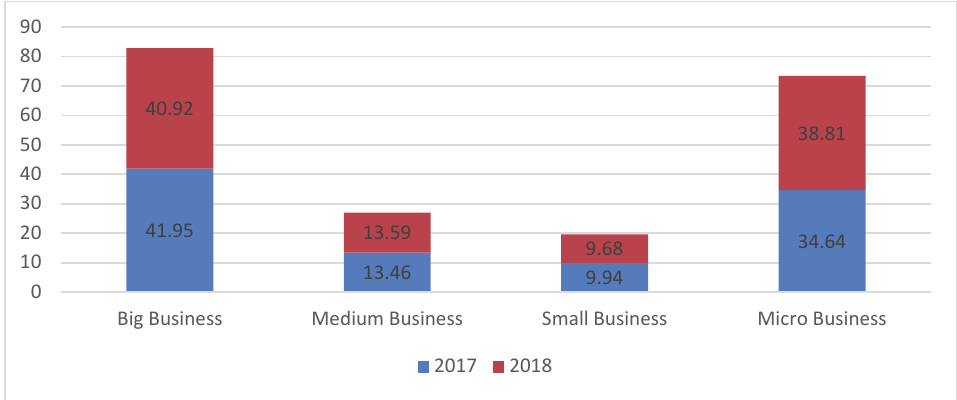
Fig. 1. Chart of MSME Development / Source: Bank Indonesia, 2018